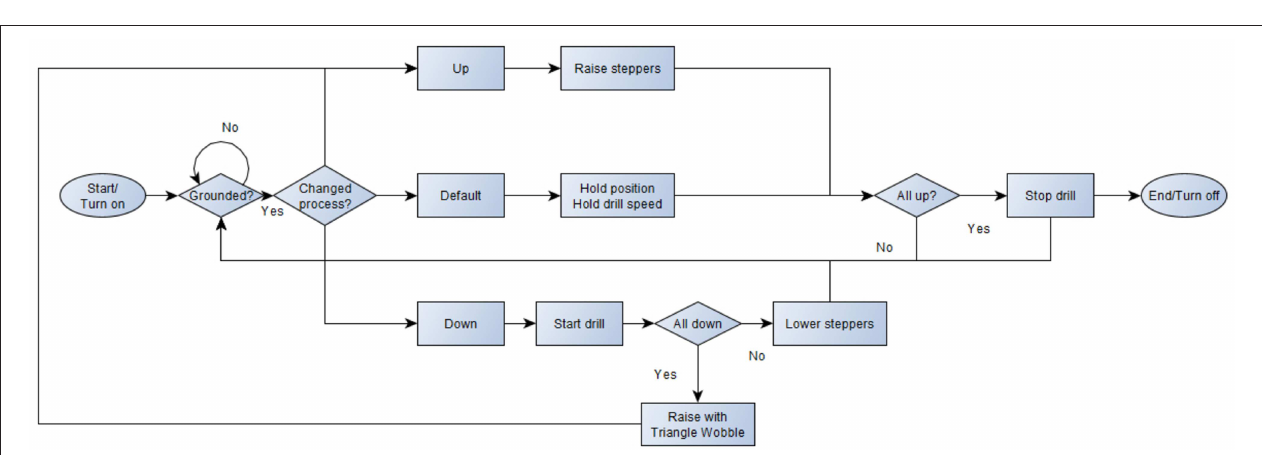
FIGURE 13 | A flow chart that summarizes the logic behind the automated drilling